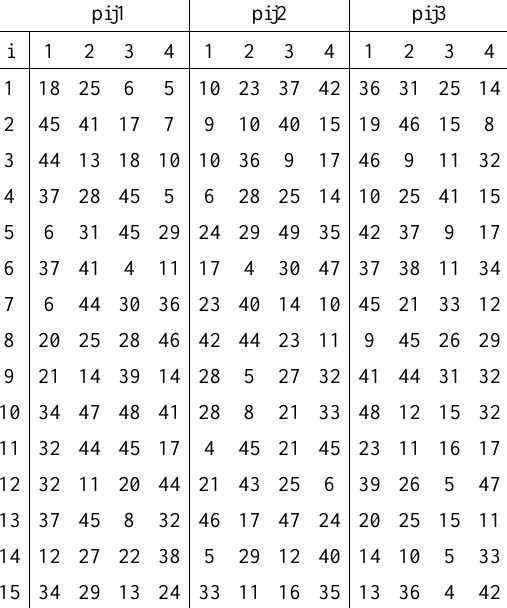
Table 1: Parameters of p ijk pij1 pij3